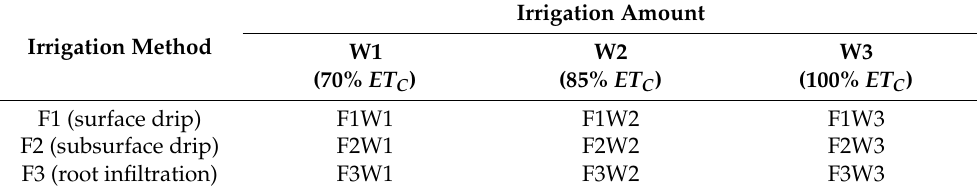
Table 1. Test design.